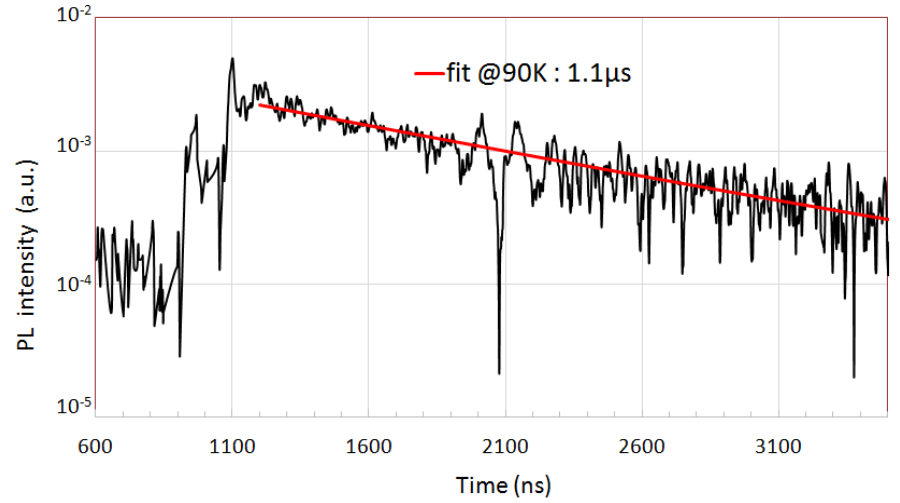
Figure 7. TRPL signal of the Ga-free InAs/InAs 0.63 Sb 0.37 T2SL structure at 90 K. A minority carrier lifetime of 1.1 µs is extracted.